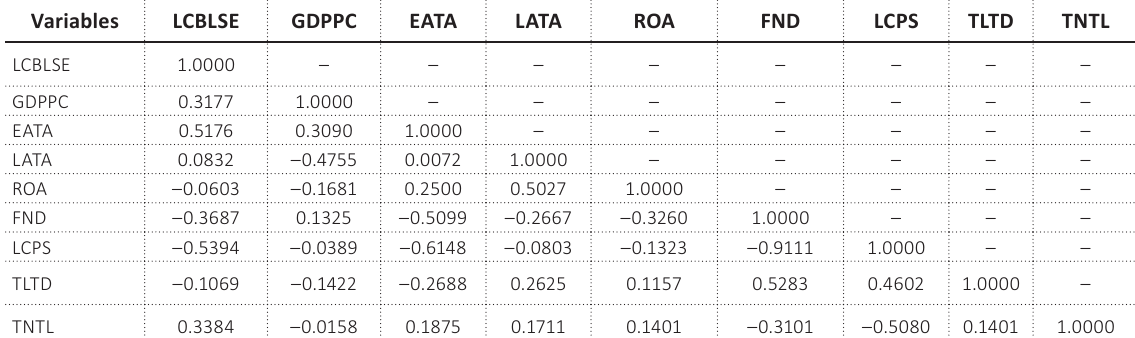
Table 3. Correlation matrix